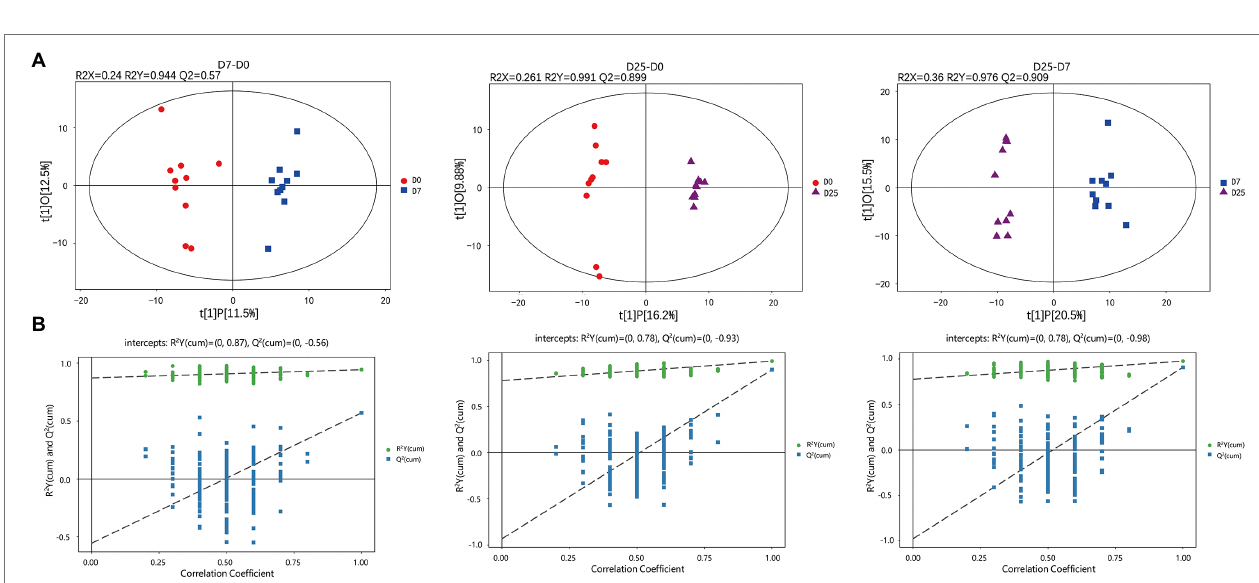
FIGURE 3 | GC-TOF/MS analysis of the livers in Landes geese overfed for 0, 7, and 25 days. Liver samples were collected from geese overfed for 0, 7, and 25 days for GC-TOF/MS analysis. The OPLS-DA score plots (A) and OPLS-DA corresponding validation plots (B) were generated among the D0, D7, and D25 groups. GC-TOF/MS, gas chromatography-time-of-flight mass spectrometry; OPLS-DA, orthogonal partial least squares discriminant